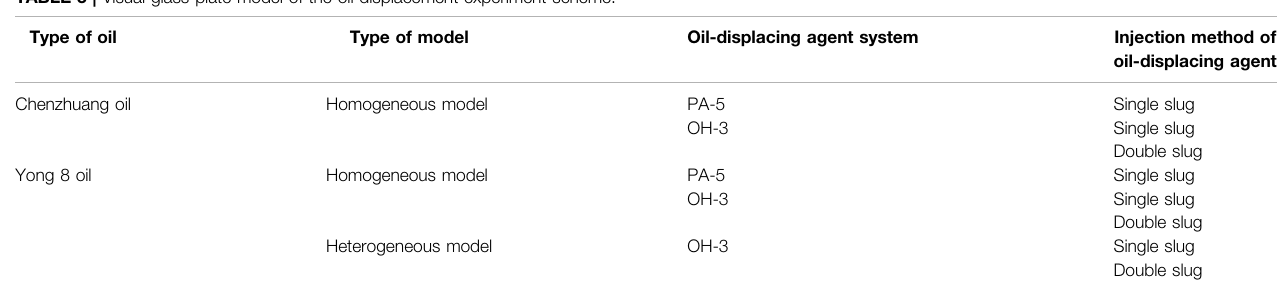
TABLE 3 | Visual glass plate model of the oil displacement experiment